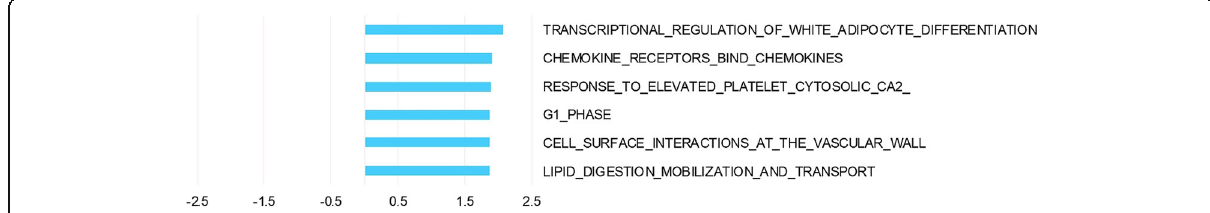
Fig. 3 Pathway analysis of the effect of surgical manipulation (warm ischemia). Pathway analysis was performed with GSEA using ranking of genes according to the time term from GEE. NES depicted for all Reactome pathways significantly altered in samples collected post-surgery compared to samples collected pre-surgery irrespective of whether it was normal or tumor tissue